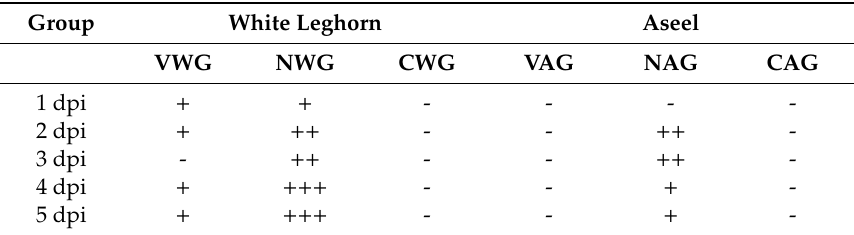
Score / Grade: - for no gross lesions and appearing normal; + for bursa slightly enlarged and edematous; ++ for edematous, enlarged or hemorrhagic bursa with changes in any of the organs (hemorrhages in thymus / necrotic foci in spleen / hemorrhage in caecal tonsils) and +++ for gross changes in all the lymphoid organs. VWG: Vaccinated challenged WLH group; NWG: Nonvaccinated challenged WLH group; CWG: WLH control group; NAG: Nonvaccinated challenged Aseel group; VAG: Vaccinated challenged Aseel group; CAG: Aseel control